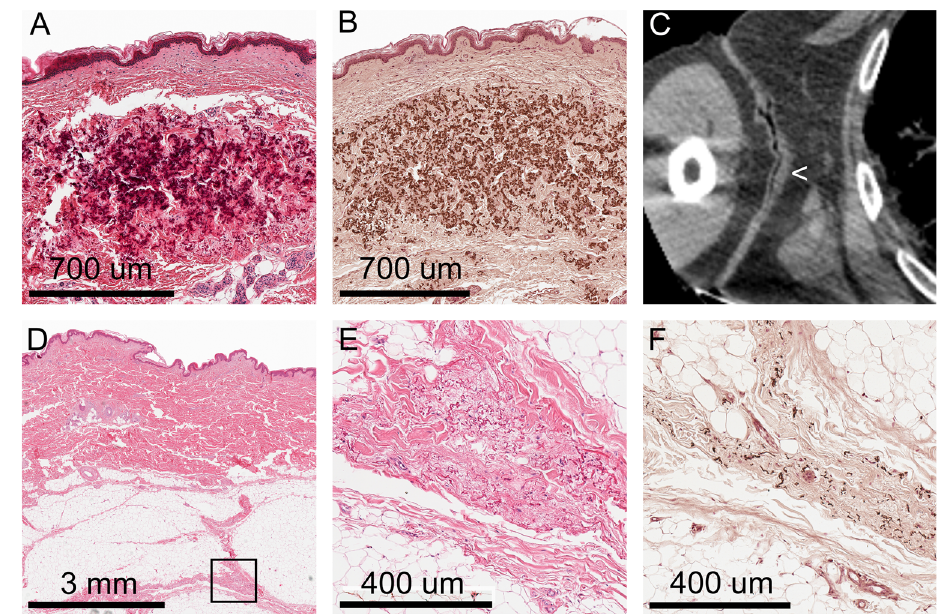
Fig. 1 Skin alterations in the pseudoxanthoma elasticum. A – C: In the axillae typical pseudoxanthoma elasticum lesions were found, consisting of clumps of degenerated elastic fibres in the mid and lower dermis (A). Von Kossa stain showed calcifications of these elastic fibres (B). On the CT scan, thickened skin (<) was seen (C). D – F: Other localisations of the skin, macroscopically unremark- able, showed degenerated elastic fibres in the septa of the subcuta- neous fatty layer. The marked